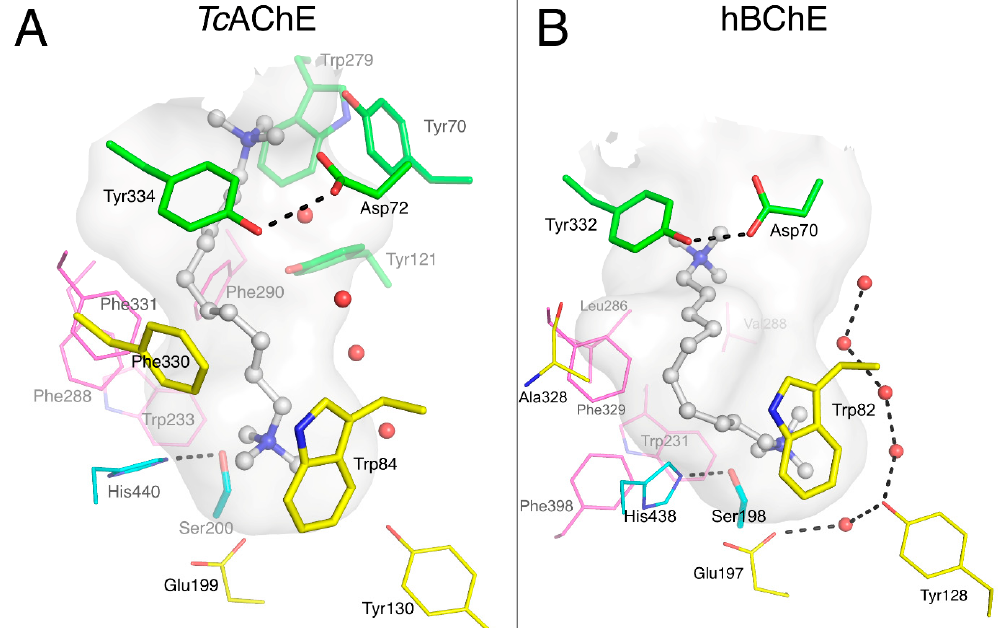
Figure 3. Complexes of decamethonium with Tc AChE ( A ; pdb 1acl) and hBChE ( B ; pdb 6ep4). The gorge is depicted by its molecular surface (semi-transparent gray). Nitrogen atoms are in blue and oxygen atoms in red. The ligand is represented in ball and stick format with carbon atoms in white. The residues in the vicinity of the ligand are represented in stick or lines. In the A-site, catalytic residues are in cyan, choline-binding pocket residues in yellow and acyl-binding pocket residues in magenta. P-site residues are in green. Conserved structural water molecules are represented in red spheres. The hydrogen bonds are represented in dashed lines.